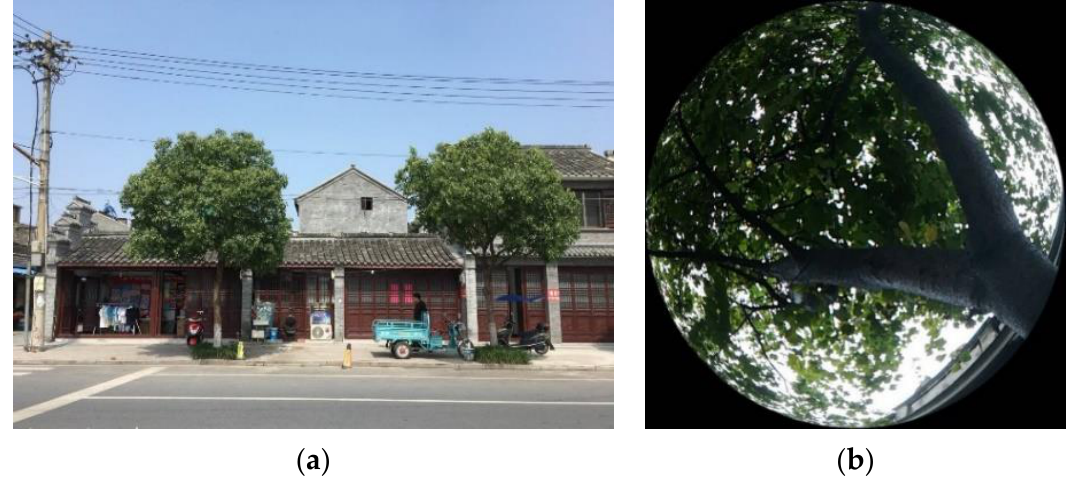
Figure 6. ( a ) A typical image of a camphor tree ( b ) Fisheye image of a camphor tree [18]. Table 4. The leaf area density (LAD) distribution of the tree [18].